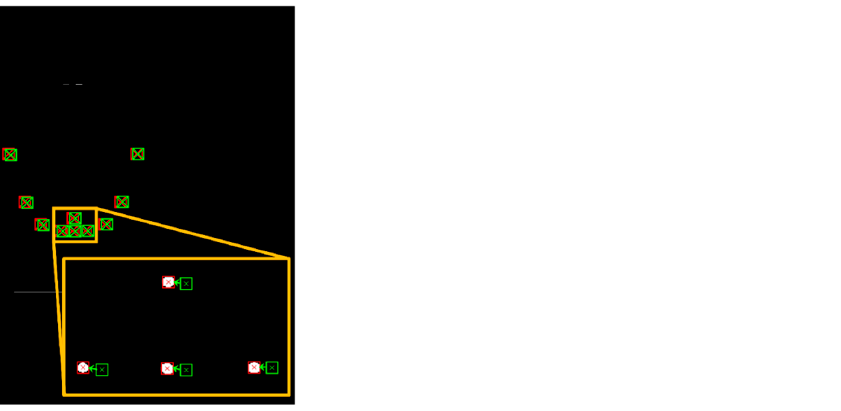
Figure 7. Graphical depiction of the matching process through Nearest Neighbor. In red: markers’ centroids found through the detection step. In green: markers’ centroids reprojected using the pose initial guess. The arrows show the detected markers to which they are matched. Particular of the matching applied to markers #7 to #10 (in orange